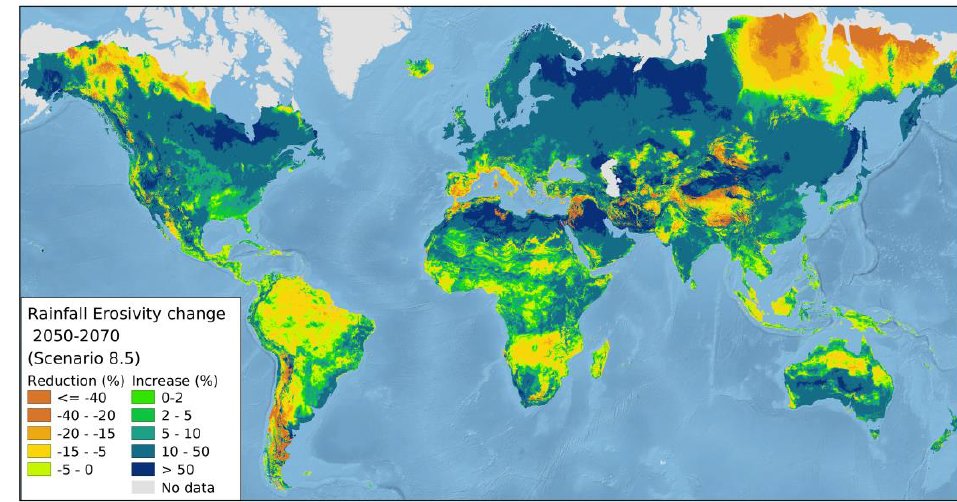
Figure 3. Erosivity projections for the period 2050 − 2070 for the scenario RCP 8.5 [56].